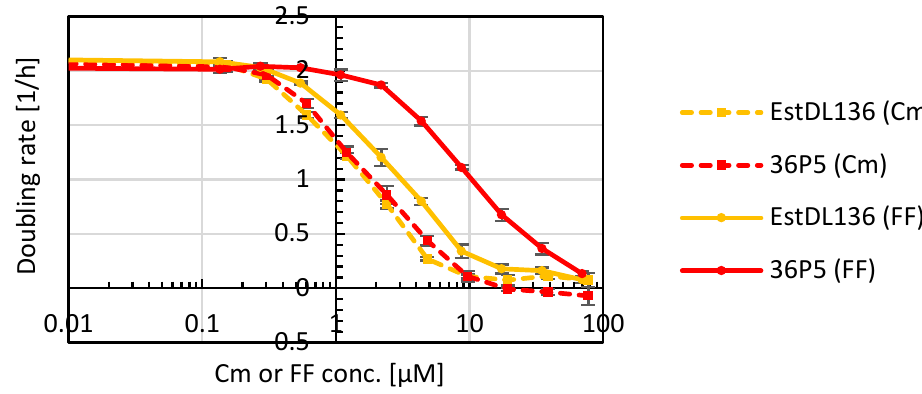
Figure 4. Comparison of wild-type hydrolase EstDL136 and mutant 36P5. Growth assay in Cm or FF of E. coli expressing either EstDL136 or mutant 36P5 ( n = 4).